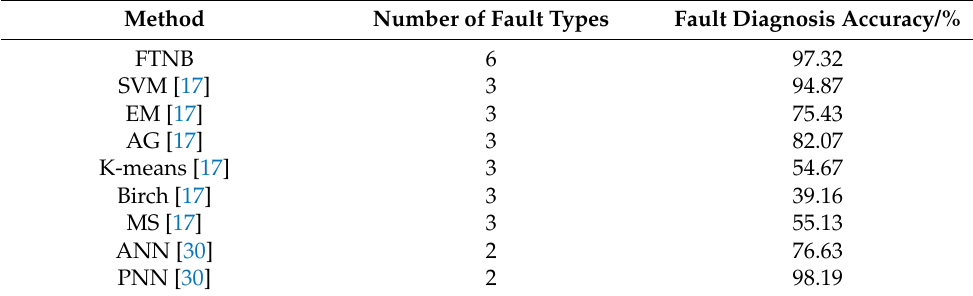
Figure 15. Fault diagnosis result with noise data based on the Naive Bayesian method. Table 1. The comparison results of the fault diagnosis